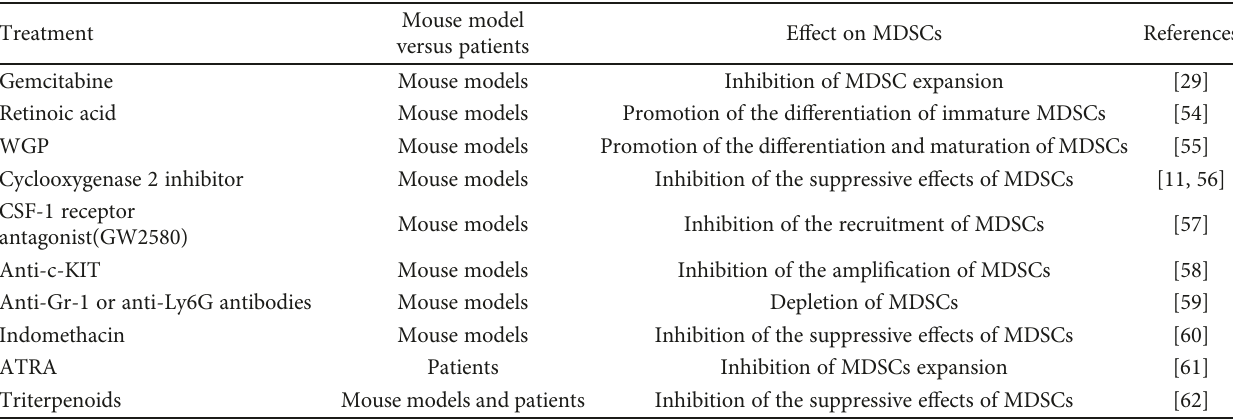
Figure 1: Targeting MDSCs in the treatment of lung cancer. Retinoic acid can stimulate the di ff erentiation of myeloid progenitor cells to dendritic cells or macrophages, thereby inhibiting the di ff erentiation of MDSCs. c-KIT can inhibit the signaling pathway which is mediated by SCF, inhibiting the ampli fi cation of MDSCs. The inhibition of COX2 expression in MDSCs can decrease the release of arginine-1, Nrf2 contributes to the clearance of ROS in MDSCs, and both COX2 and Nrf2 can inhibit the function of MDSCs. The above measures will inhibit MDSCs ’ immunosuppressive function on e ff ector T cells and enhance the antitumor immunity. SCF: stem cell factor; VEGF: vascular endothelial growth factor; COX2: cyclooxygenase 2; Arg-1: arginine-1; Nrf2: nuclear factor erythroid 2 p45-related factor 2; ROS: reactive oxygen species; CTL: cytotoxic lymphocyte. Table 1: Regulation of MDSCs in lung